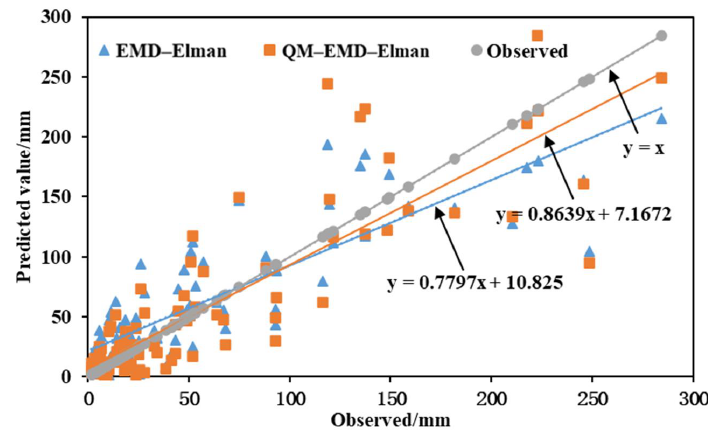
Figure 11. Scatter fit plots of the predictive value of two models.